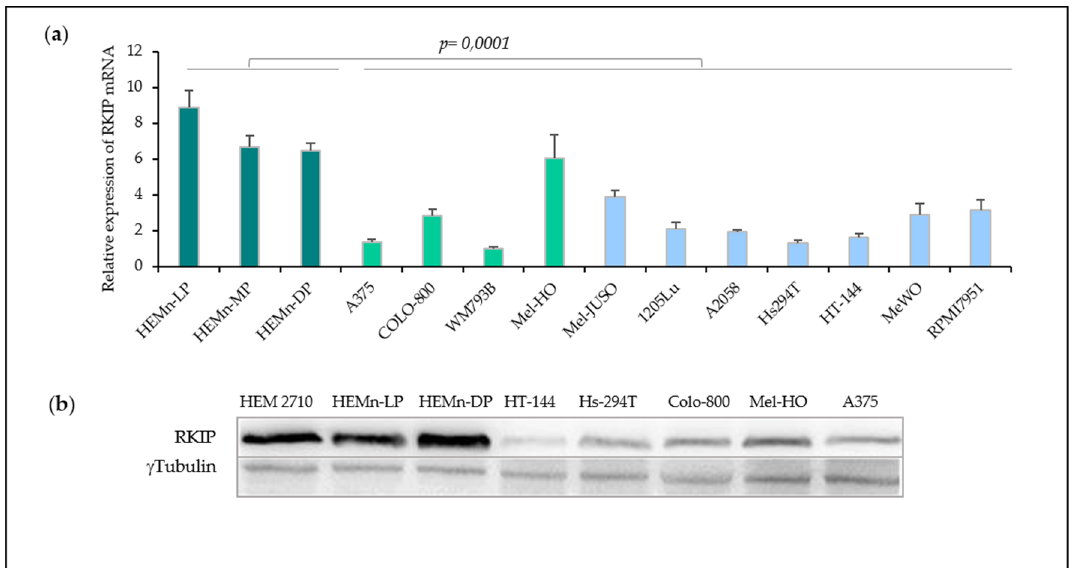
Figure 2. RKIP expression in cell culture of primary melanocytes and melanomas. ( a ) RKIP mRNA expression in primary melanocytes and melanoma cell lines. RNA from three human melanocytes (dark green) lightly (HEMn-LP), moderately (HEMn-MP), and darkly (HEMn-DP) pigmented neonatal foreskin lines together with four primary melanomas cell lines (light green) and seven metastatic melanomas cell lines (light blue) were analyzed by RT-qPCR. ( b ) RKIP protein expression in the three melanocytes cell lines and five melanoma cell lines assessed by Western Blot. Tubulin expression was used as loading control. Figure is representative of three independent experiments.